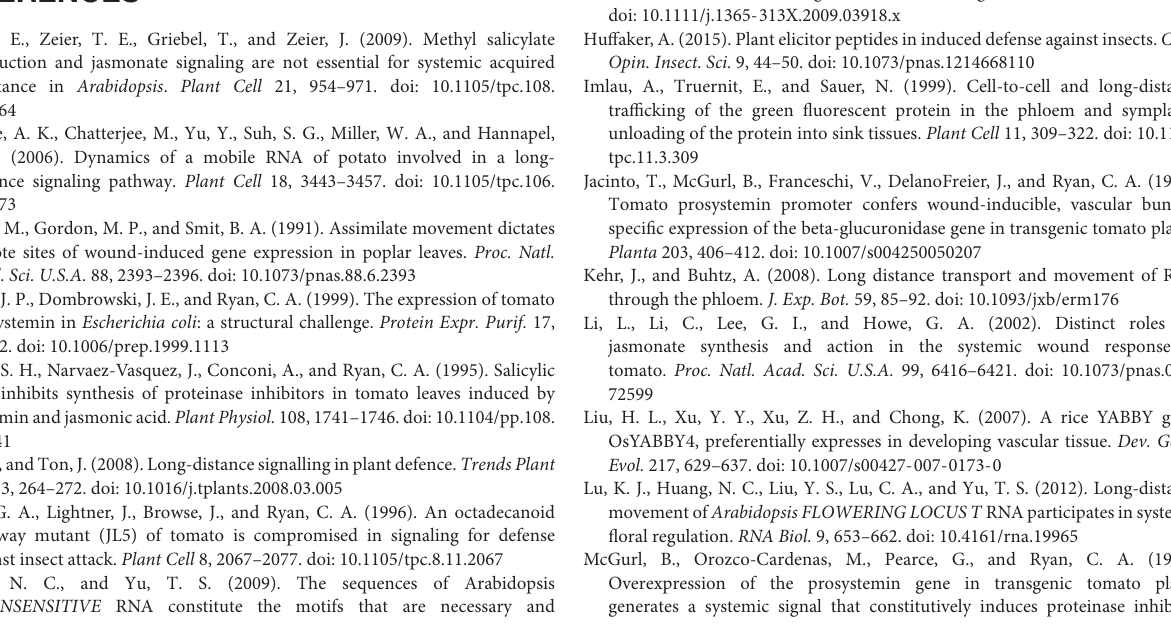
FIGURE S1 | Coomassie-stained SDS-PAGE gel showing the positions of purified PS-GFP and SYS-GFP. Fusion proteins were purified by Ni-chelating affinity chromatography. Both PS-GFP and SYS-GFP expressed in E. coli exist in the supernatant (Su) of the lysate and the sediment (Se). Arrowheads indicate the bands of PS-GFP and SYS-GFP with a molecular weight of ∼ 67 kD and ∼ 30 kD, respectively. Cr denotes the crude supernatant of E. coli . The positions of molecular weight markers are